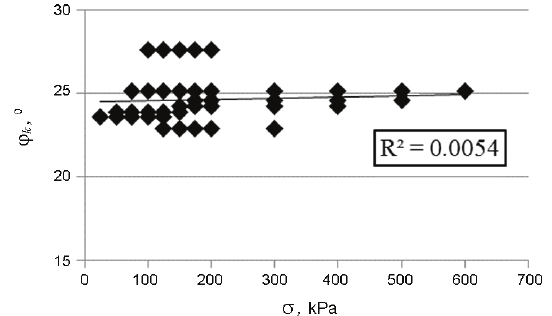
Fig. 13. The angle of internal friction versus vertical stress (results of 15 tests)